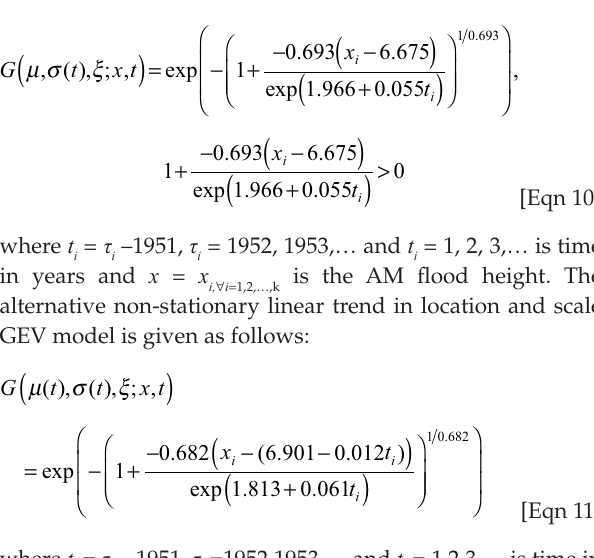
FIGURE 3: Diagnostic plots for the time-heterogeneous generalised extreme value model with a trend in the scale parameter at Combomune hydrometric station: (a) Residual probability plot; (b) Residual quantile